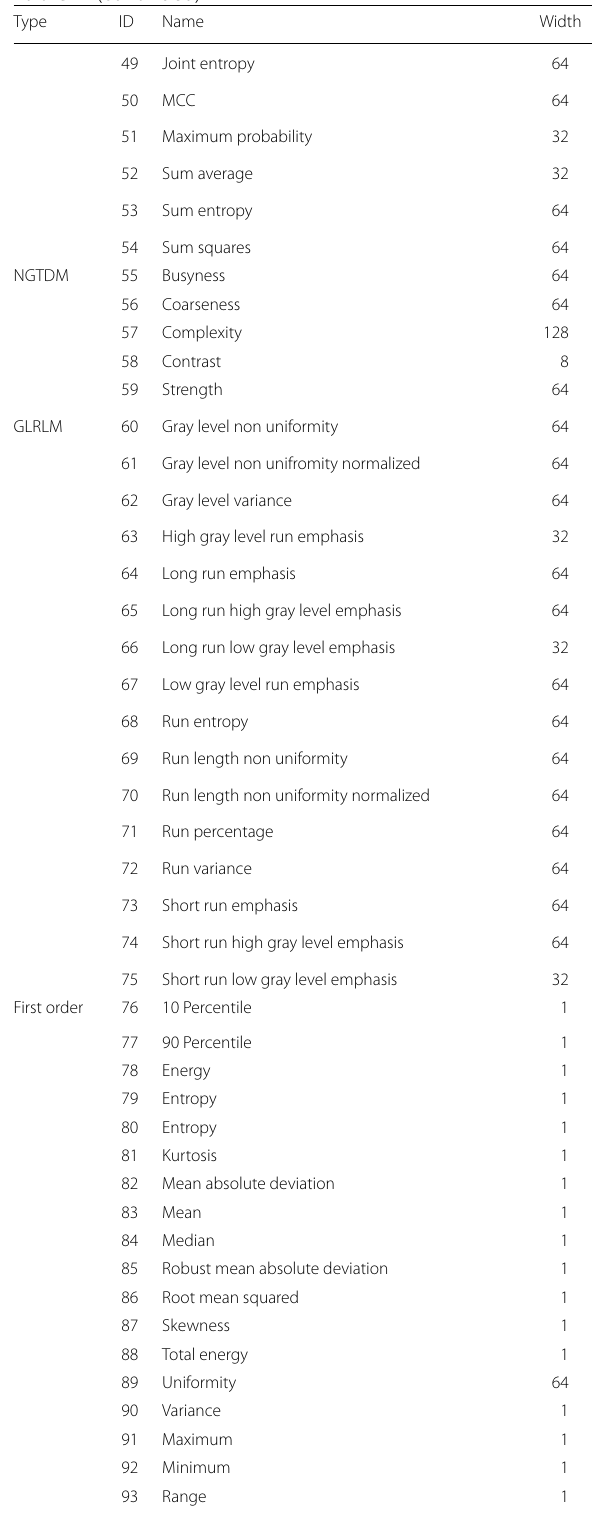
did not exhibit any correlation with the age of